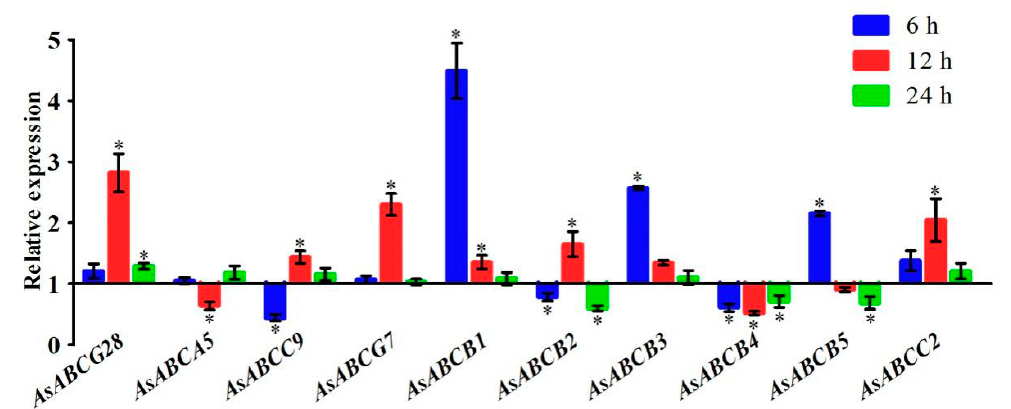
Figure 6. Expression changes of ten ABC transporter genes after pyrethroid treatment for A. sinensis female adults. The ten genes include four genes ( AsABCG28 , AsABCA5 , AsABCC9 , and AsABCG7 ) that are significantly upregulated in RNA-seq and qPCR analyses in different resistant population, and six genes ( AsABCB1 , AsABCB2 , AsABCB3 , AsABCB4 , AsABCB5 , and AsABCC2 ) that have been reported to be associated with pyrethroid resistance. The expression levels (means ± SD) were determined at 6-h, 12-h, and 24-h postpyrethroid treatment using qPCR with three biological replicates. The samples marked with “*” were significantly differently expressed ( p -value < 0.05) compared with the untreated samples at the same time, and the samples without “*” were not significantly differently